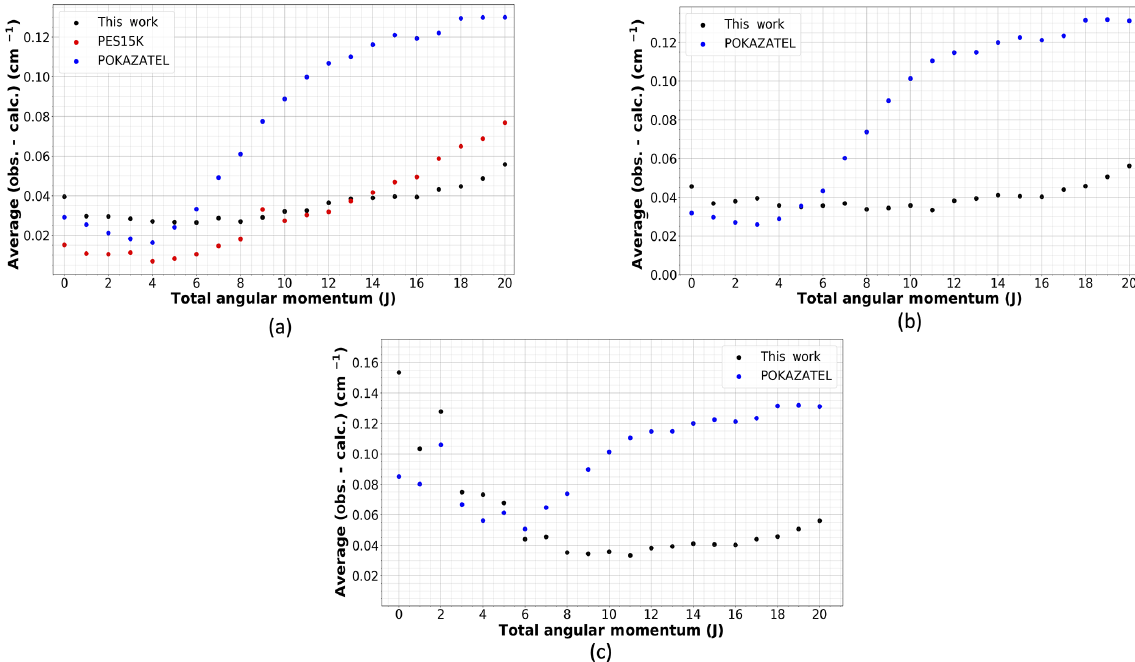
Figure 1. The average deviation of calculated levels from those in MARVEL (Furtenbacher et al., 2020) using several potential energy surfaces: this work, POKAZATEL (Polyansky et al., 2018) and PES15K (Mizus et al., 2018). (a) Energies below 15000cm − 1 , (b) energies below 26000cm − 1 and (c) energies below 37000cm − 1 .